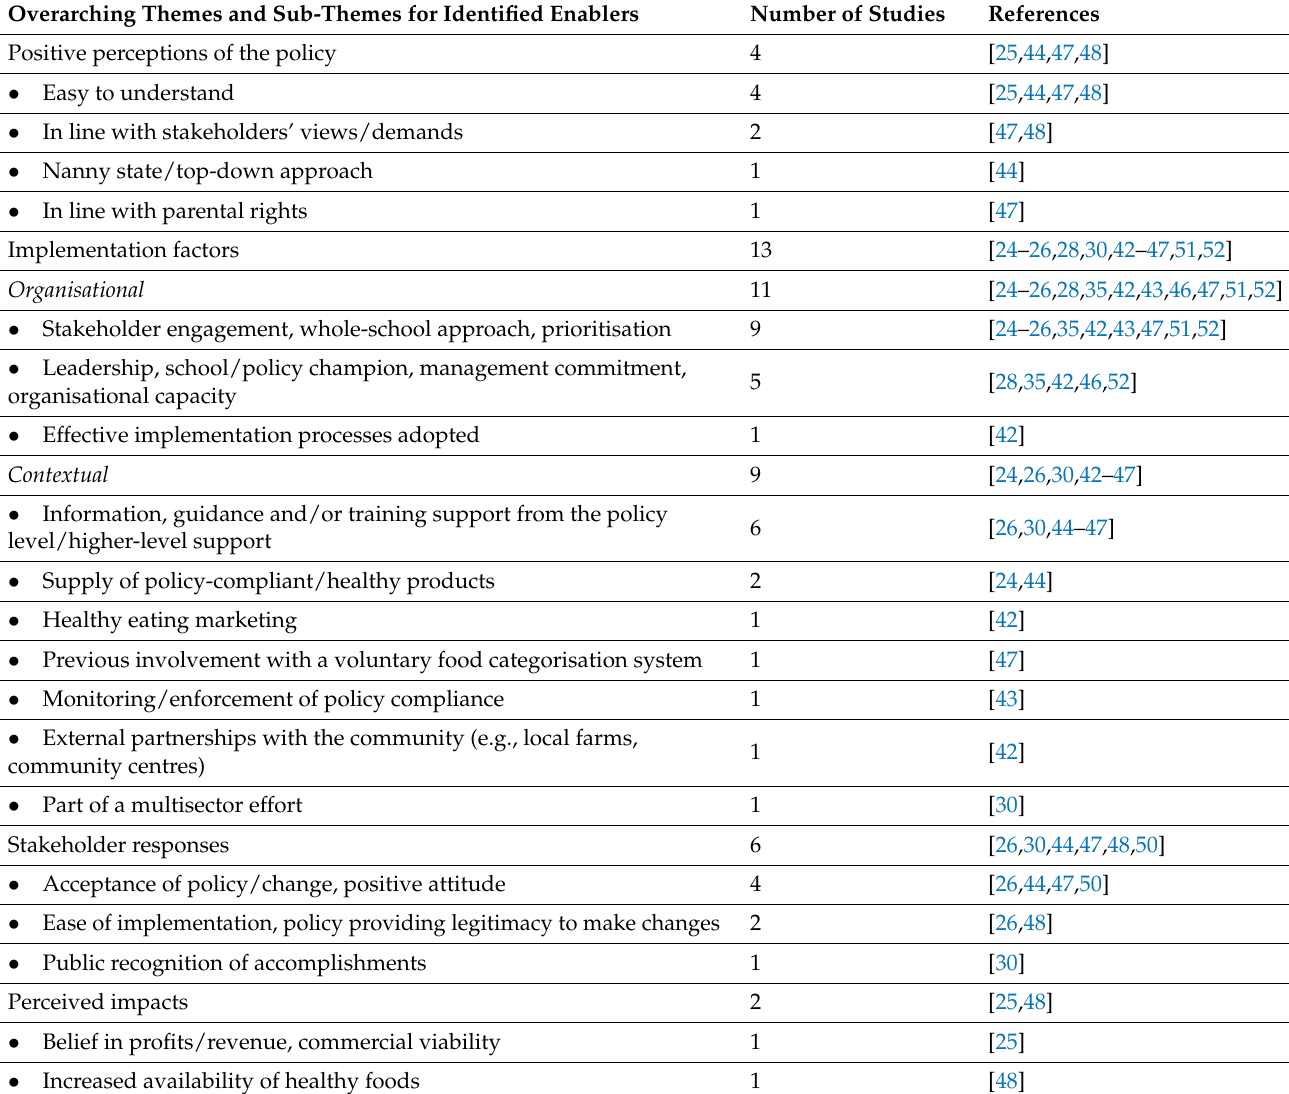
Table 3. Enablers identified in included studies according to overarching themes and sub-themes. Overarching Themes and Sub-Themes for Identified